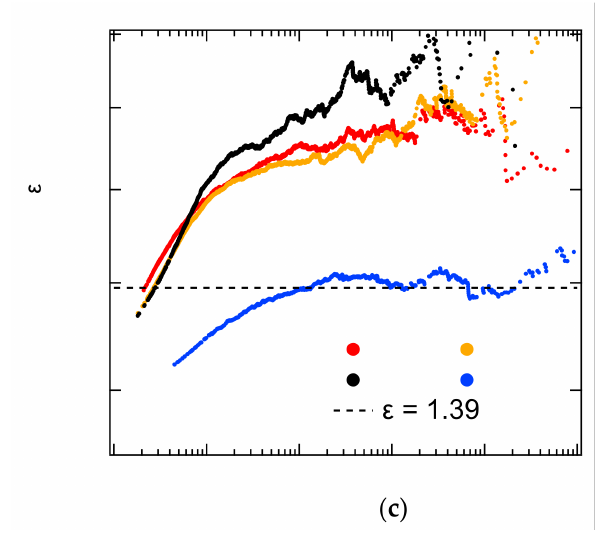
Figure 11. ( a ) AE energy spectra with a series of active periods, n = 1, 2, 3, and 4. The red continuous curve represents the energy average of 30 consecutive events. ( b ) Distribution of avalanche energies for n = 1 and n = 4 in creep experiments. ( c ) The ML-fitting exponent ε as function of the lower threshold E min for n = 1, 2, 3, and 4. The horizontal dashed line ( ε = 1.39) indicates the result from Vycor compression. Reproduced with permission from [79]. AIP Publishing,